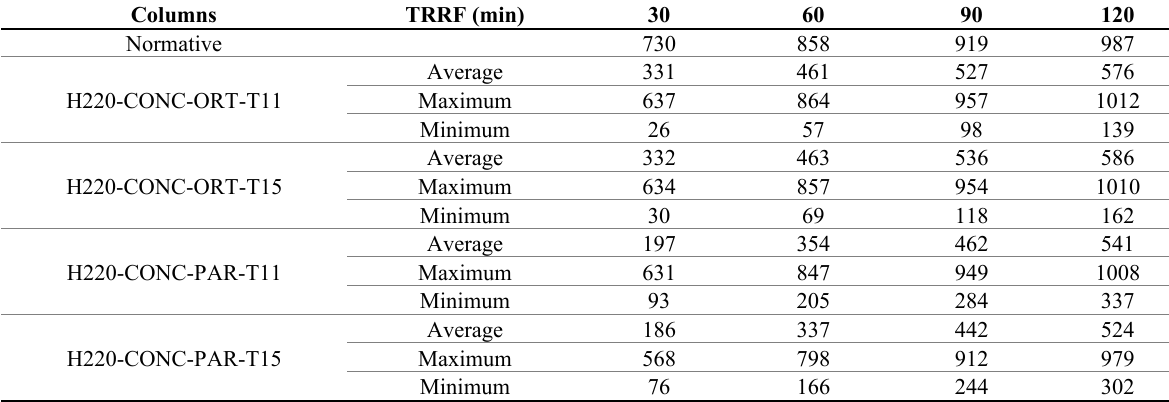
Table 4. Temperatures obtained in the numerical model on the steel profile flanges for the composite columns inserted into walls. Columns TRRF